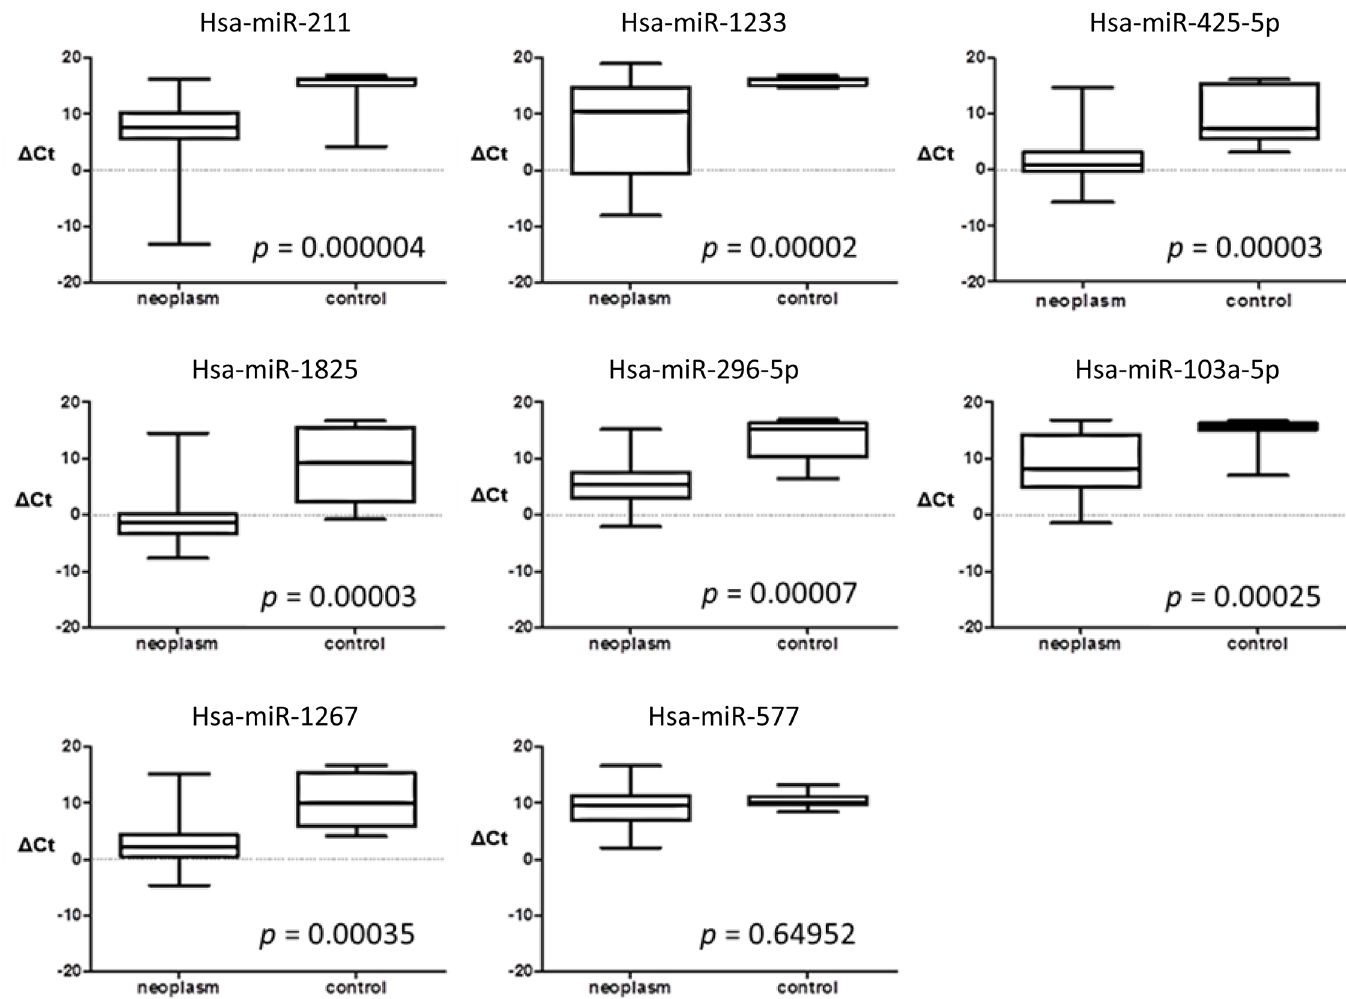
Fig 2. Box-and-whisker plot of the validation of miRNA expression in whole saliva samples. Samples were collected from patients with a parotid gland neoplasm (n = 46) and controls (n = 14). Whiskers represent maximum and minimum Δ Ct values. * p < 0.